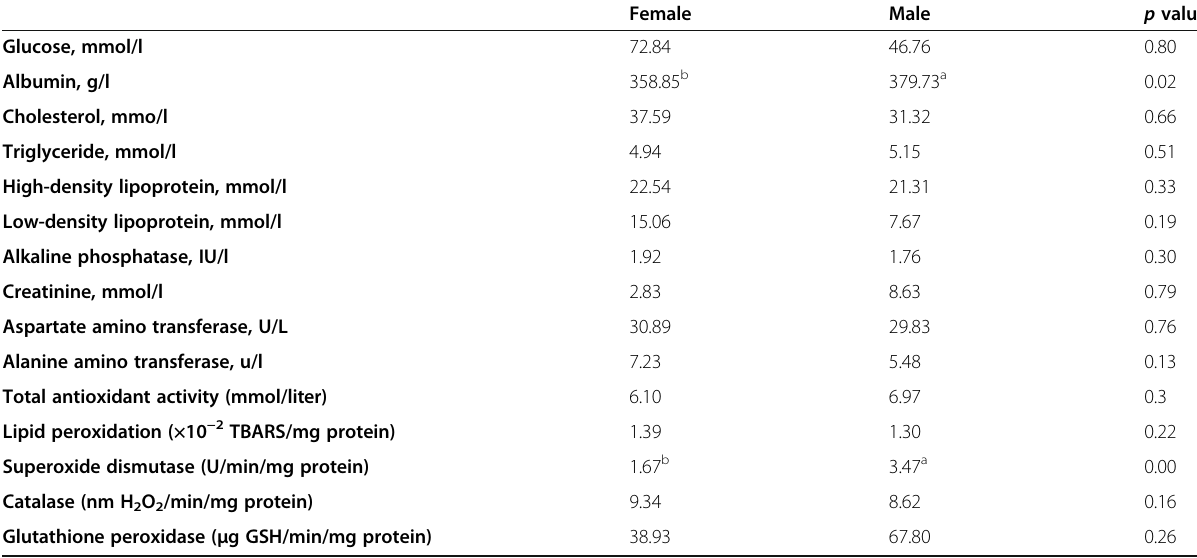
Table 3 Sexual dimorphism in metabolic and antioxidant status of Clarias